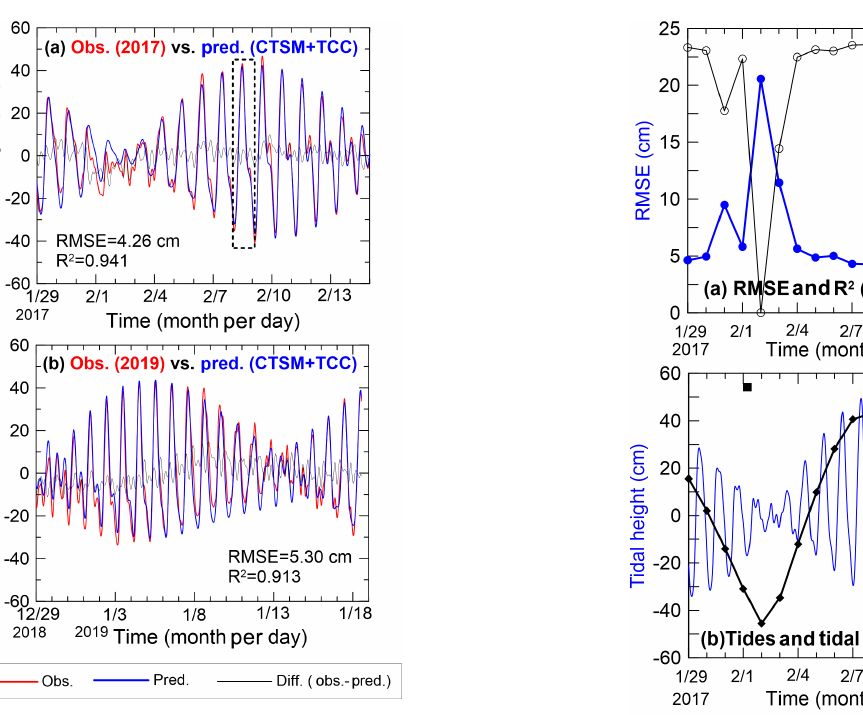
Figure 5. Time series of JBARS sea level observations (obs.), pre- dicted tidal heights (pred.), and sea level residuals (diff.) from (a) 29 January to 14 February 2017; and (b) 29 December 2018 to 18 January 2019. The JBARS predictions were generated via the CTSM + TCC method using a daily (25h) slice of local sea level observations from 8 February 2017 (dashed box in panel a ), along with concurrent (to time periods a and b ) ROBT predictions; and year-long (2017) 5min interval ROBT tidal predictions. RMSE and R 2 denote the comparison root mean square errors and coefficients of determination, respectively.